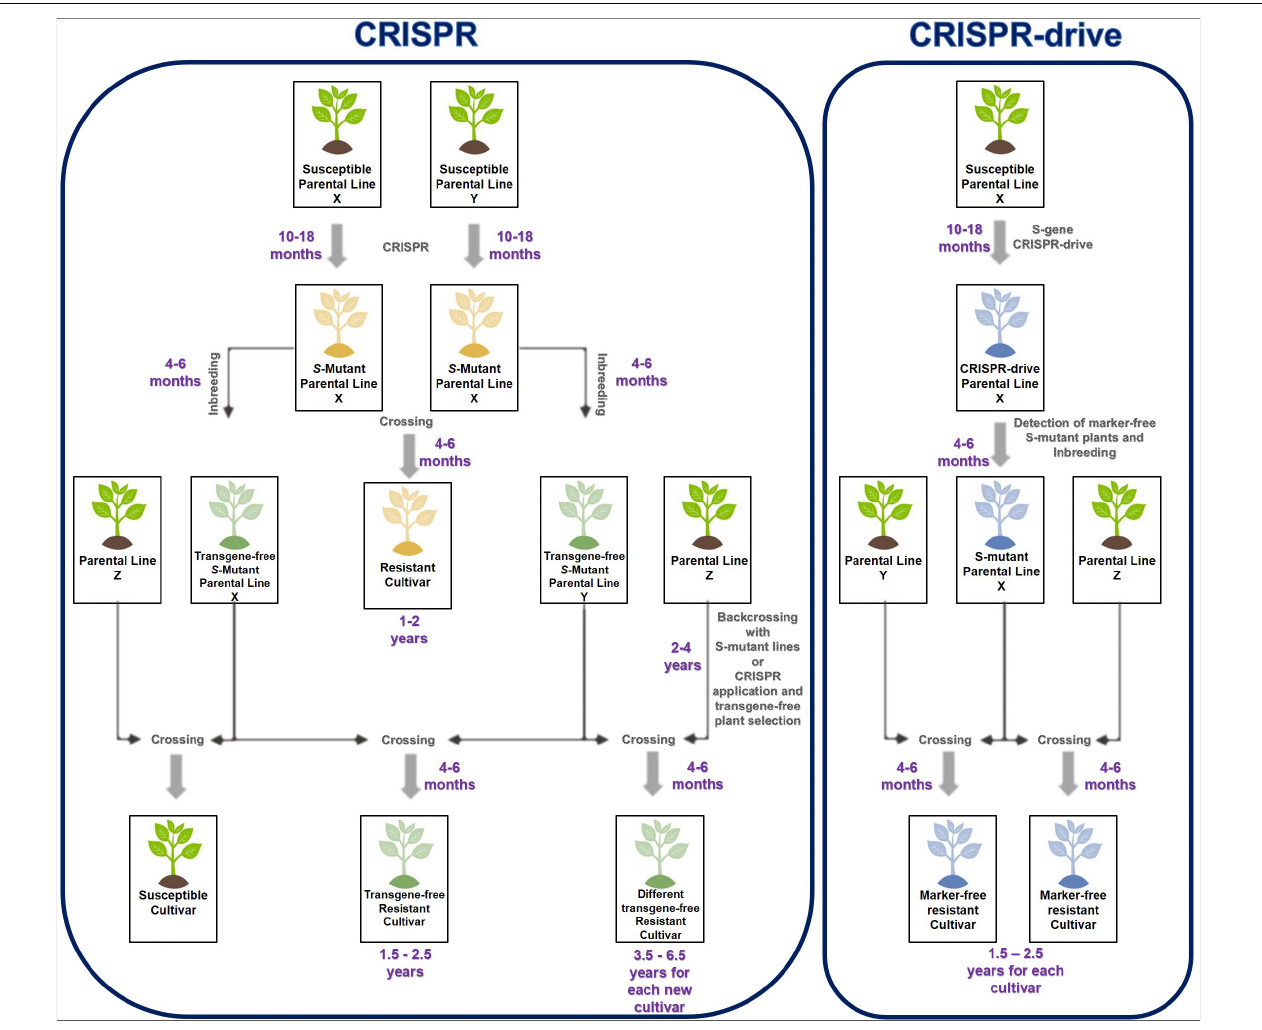
FIGURE 2 | Comparison of CRISPR and CRISPR drive process to develop S -mutant cultivars against pathogens. CRISPR lets to generate resistant cultivars in a shorter time than traditional plant breeding. When CRISPR is used for new cultivars and transfers S -gene mutation to the cultivars, CRISPR must be reapplied to acquire resistance against pathogens. Alternatively, backcrossing is carried out to gain resistance from another parental line (Z). However, CRISPR drive could eliminate repetitive CRISPR application and backcross process when CRISPR drive carrying parental line (blue-X) pollinated with different parental lines (Y or Z), CRISPR drive actives and Cas9 cuts second S -allele on another parental line. CRISPR drive has copied itself on the second S -allele during HDR and disrupted the S -alleles. Only homozygous S -mutants plants are obtained from the result of crossing between these parental